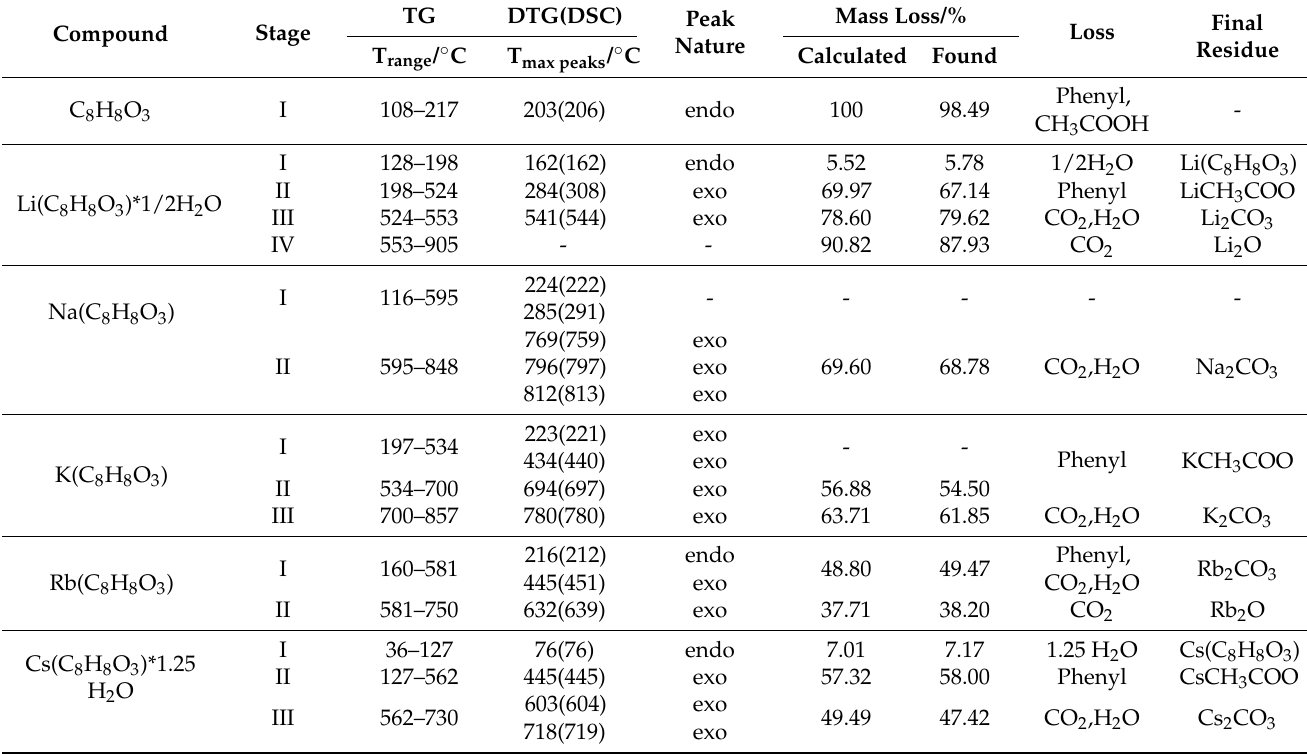
Table 4. Thermoanalytical results (TG, DTG, and DSC) for the 2-HPAA and its alkali metal salts (processed under an air atmosphere).